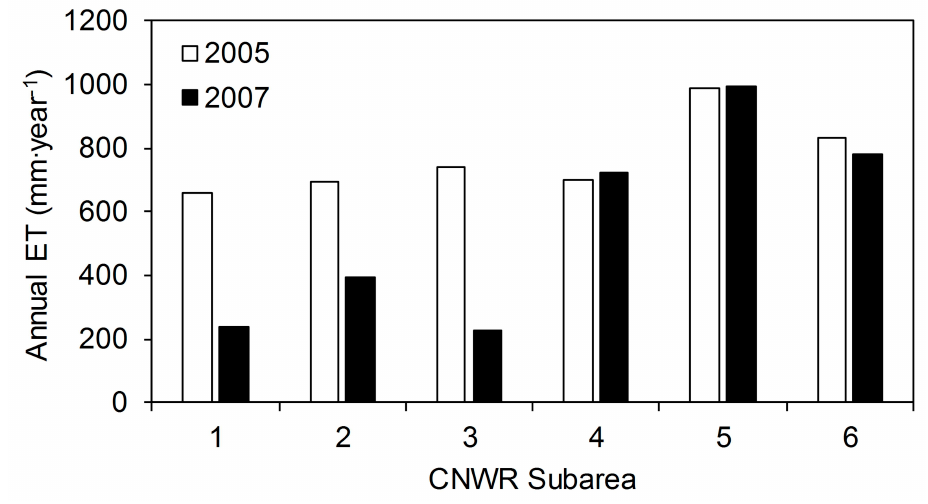
Figure 11. Annual SSS-ET for each CNWR subarea before and after the wildfire of 2006.